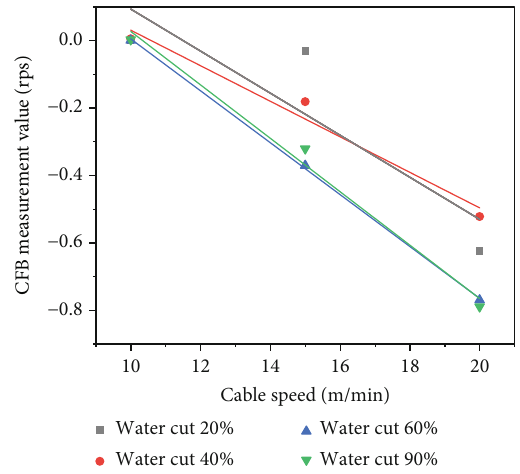
Figure 11: Relational graph of the measured value of 90 ° inclination of 300 m 3 /d CFB and cable